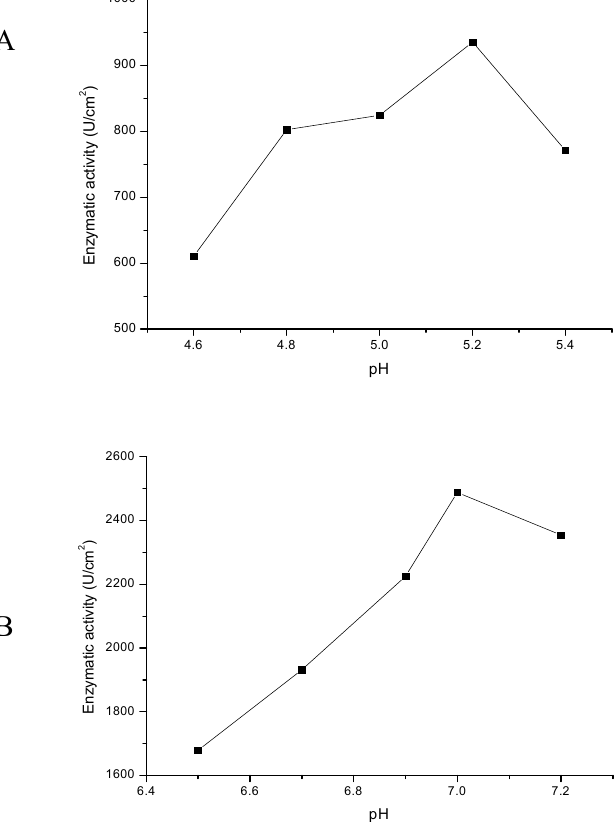
Figure 7. Activity of the immobilized laccase ( A ) and horseradish peroxidase ( B ) at various pH levels.